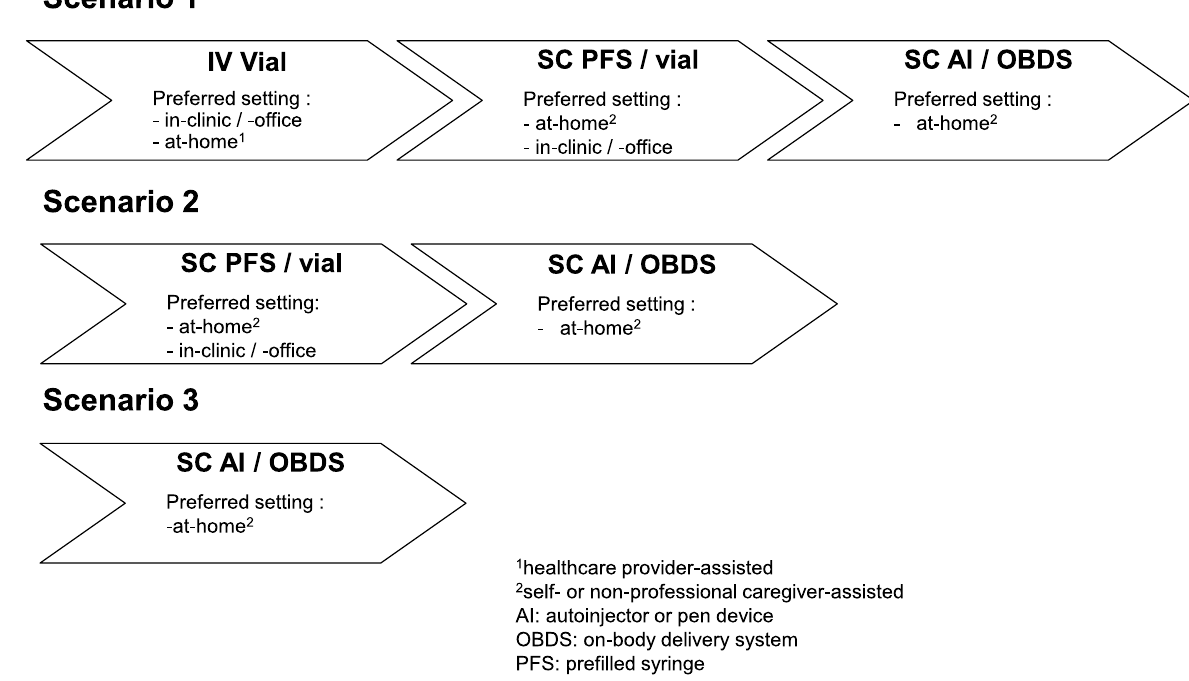
Fig. 3 Possible launch scenarios for intravenous versus subcutaneous dosing regimens for